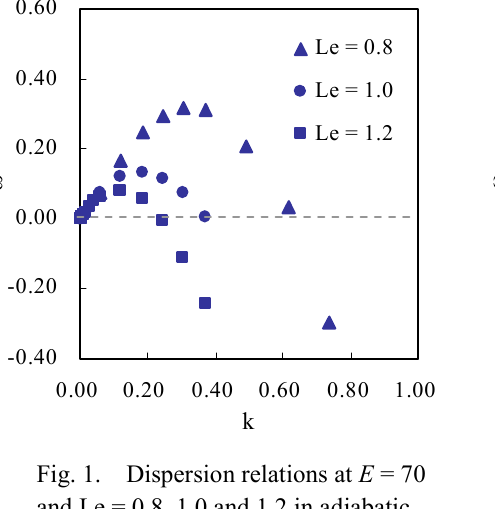
Fig. 1. Dispersion relations at E = 70 Fig. 2. Dispersion relations at Le = 1.0 and Le = 0.8, 1.0 and 1.2 in adiabatic and E =35, 70 and 140 in adiabatic and flames. non-adiabatic